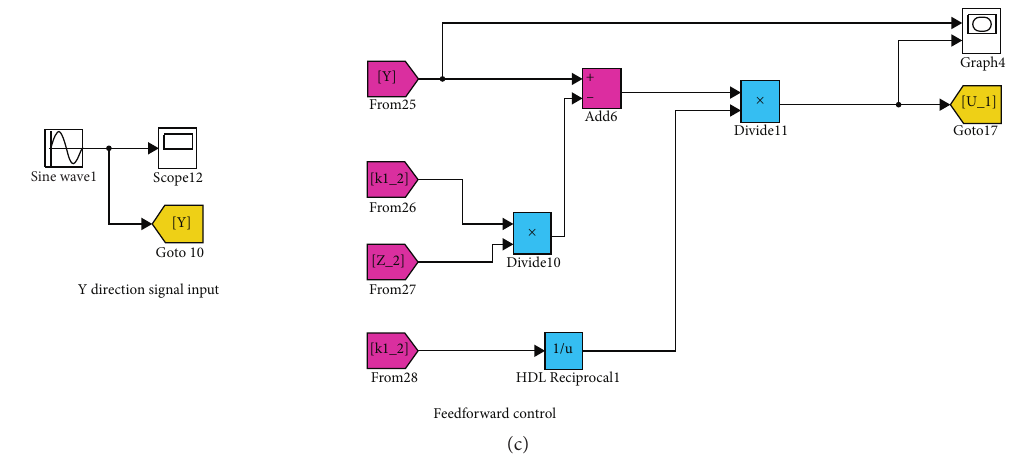
Figure 8: Decoupling control design in the X -direction. (a) Decoupling control in the X -direction. (b) The coupling model from the Y -direction. (c) The corresponding control voltage from the Y -direction (input signal of the coupled